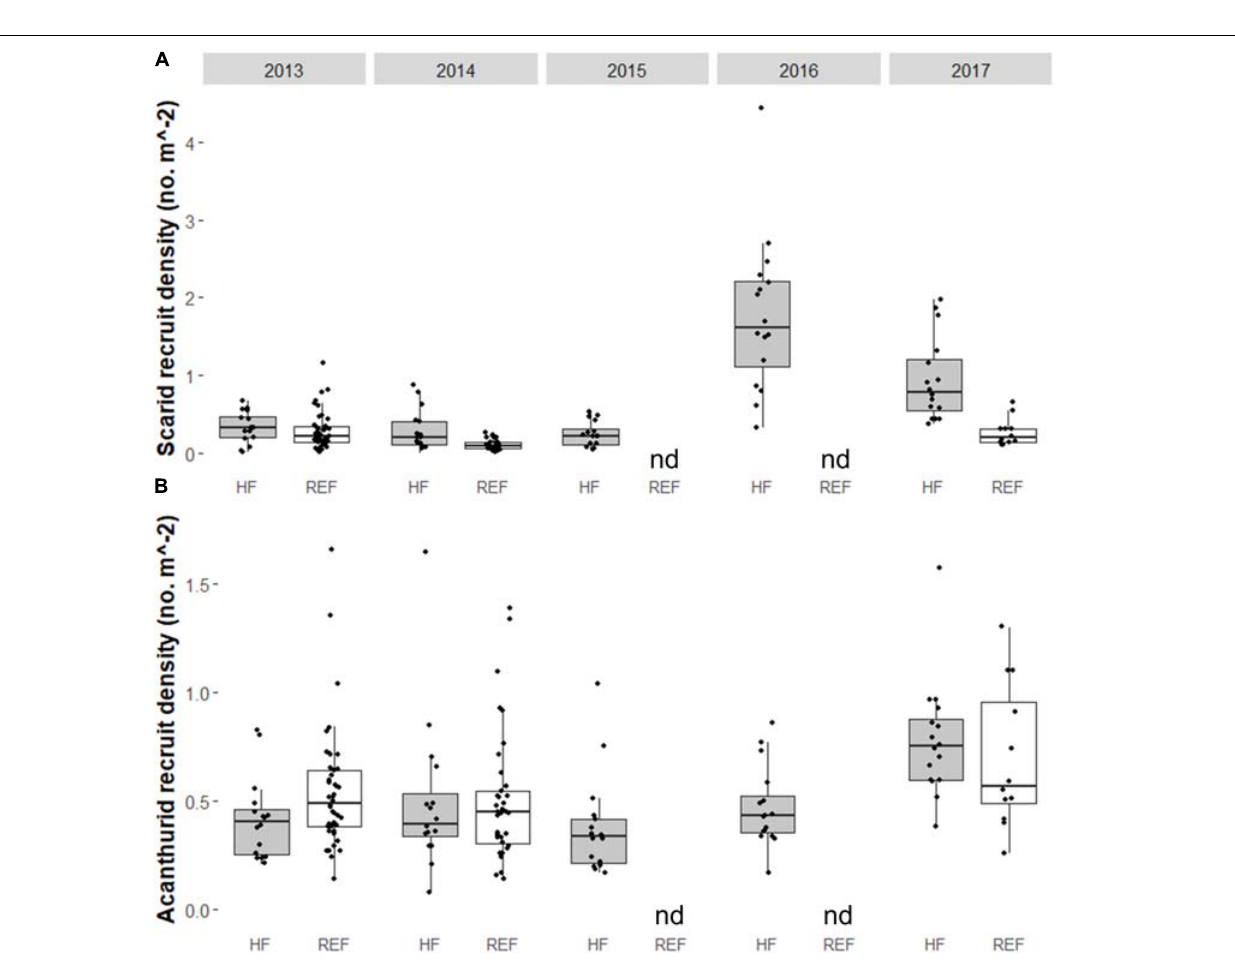
Frontiers in Marine Science |